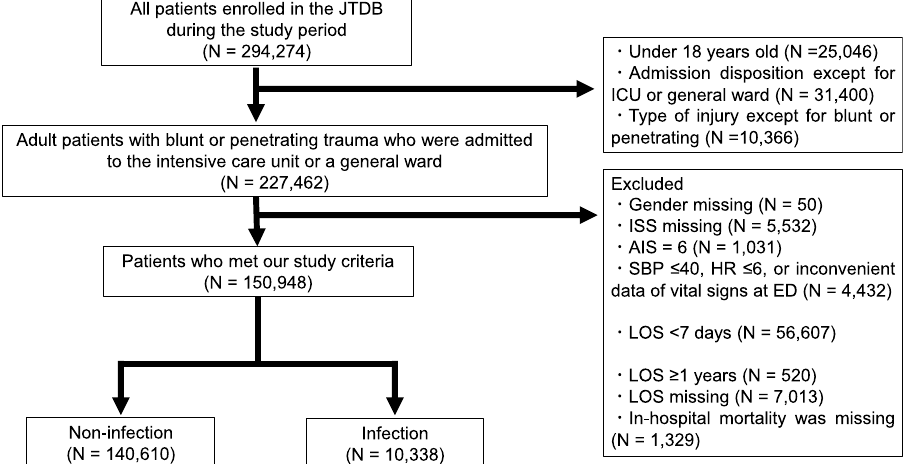
Figure 1. Patient selection. JTDB Japan Trauma Data Bank, ICU intensive care unit, ISS Injury Severity Score, AIS Abbreviated Injury Scale, SBP systolic blood pressure, HR heart rate, ED emergency department, LOS length of hospital